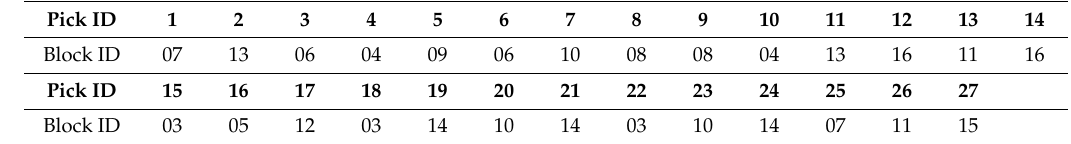
Table 1. Every Pick of the example test.